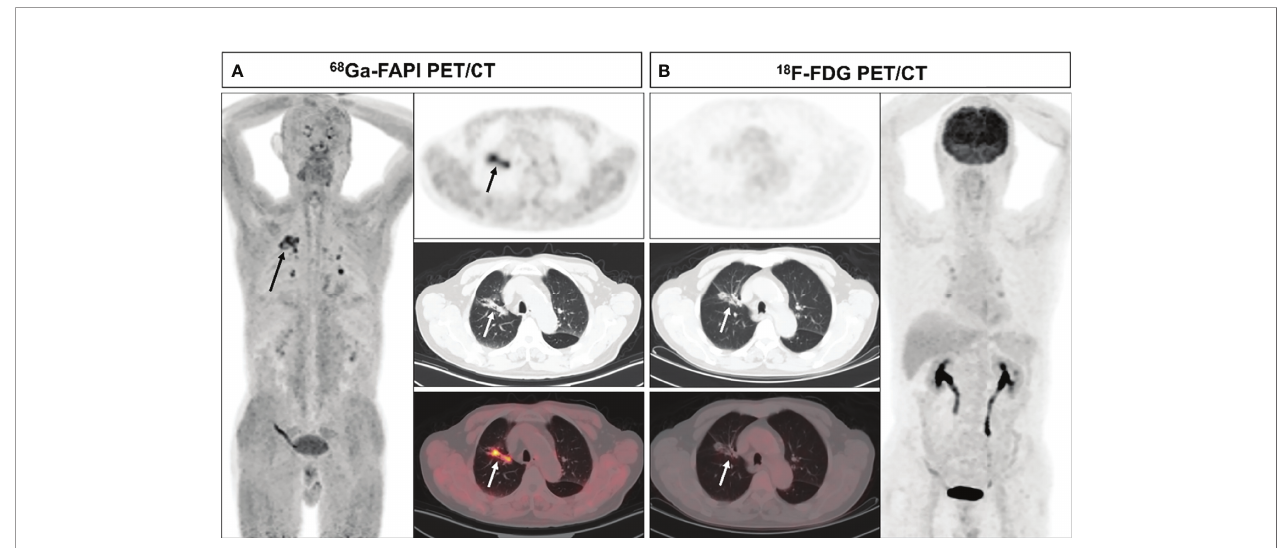
FIGURE 1 | A 70-year-old male (patient 9) diagnosed with adenocarcinoma. 68 Ga-FAPI PET/CT (A) revealed an adenocarcinoma lesion with increased FAPI uptake (solid arrows, SUVmax=6.3), while 18 F-FDG PET/CT did not reveal any signi fi cant uptake in the primary lesion (B) solid arrows).